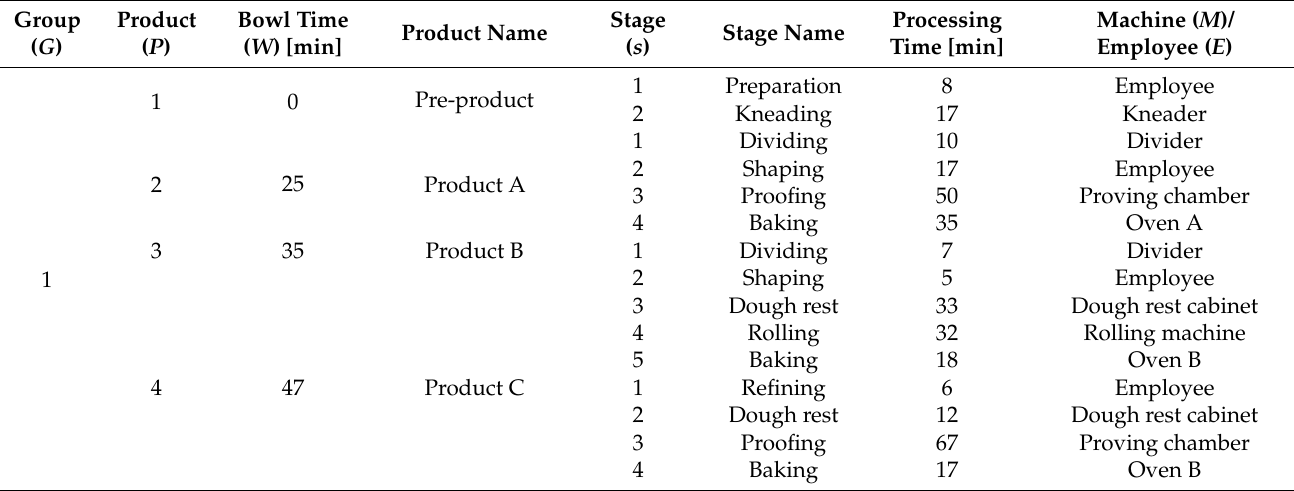
Table 1. A simplified structure of data for one product